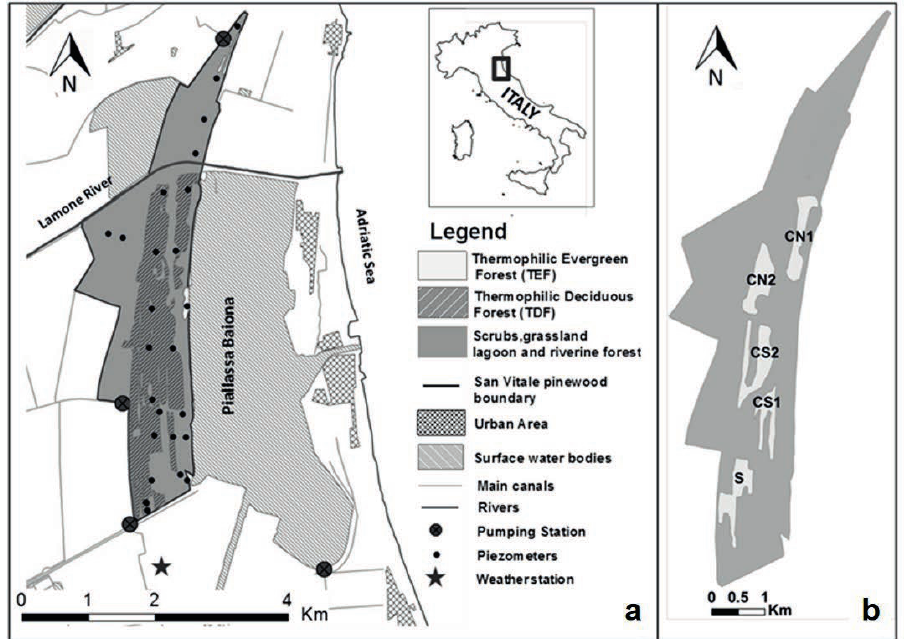
Fig. 1 San Vitale pinewood map with: (a) the vegetation types and the main hydrologic characteristics (brackish lagoon – Piallassa, rivers, main drainage channels), and (b) identification of the